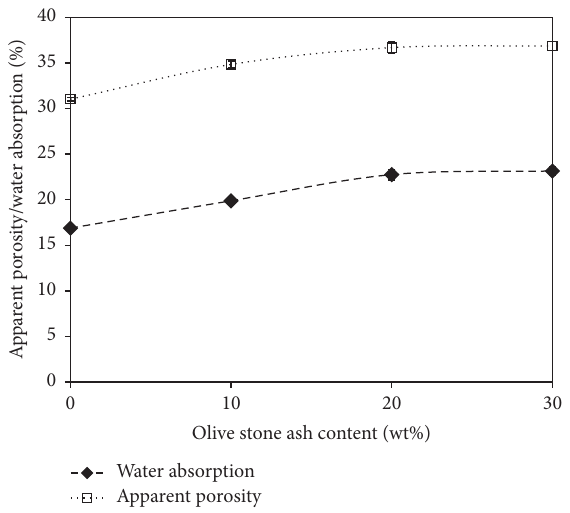
Figure 7: Apparent porosity and water absorption of the fired bricks as function of olive stone ash addition.